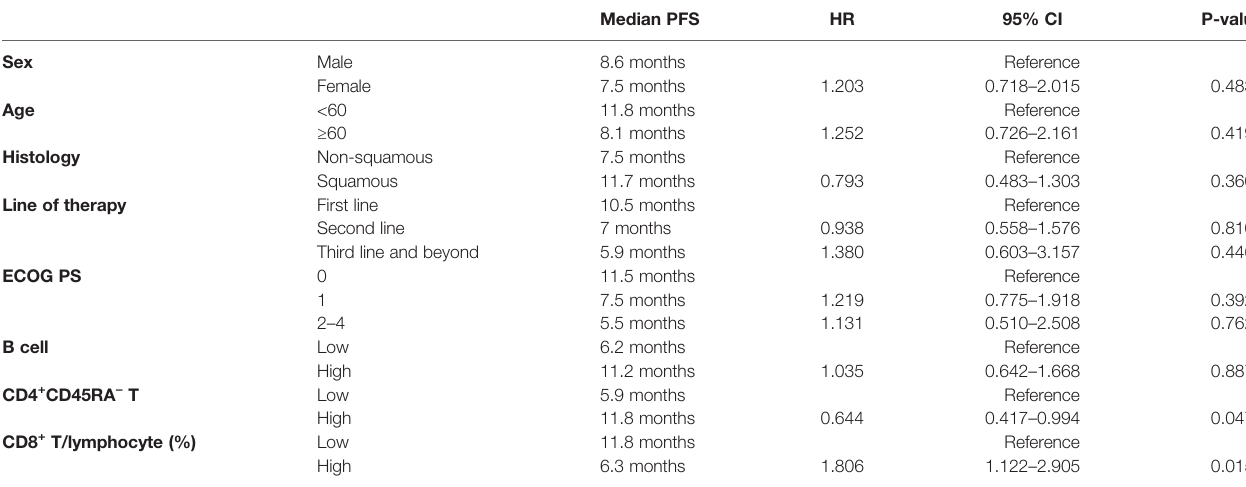
TABLE 3 | Multivariate Cox regression of PFS.